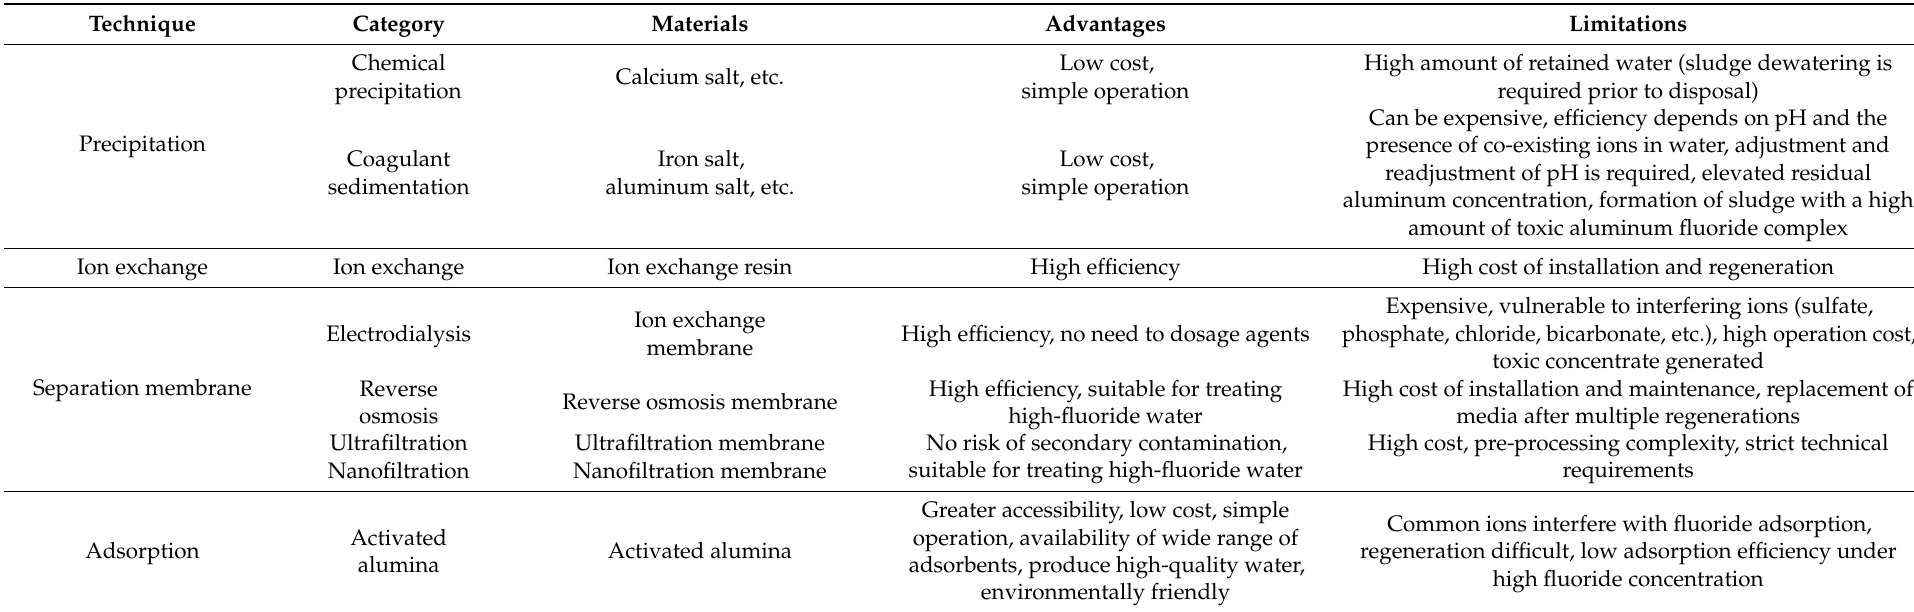
Table 1. Comparative analysis of fluoride removal